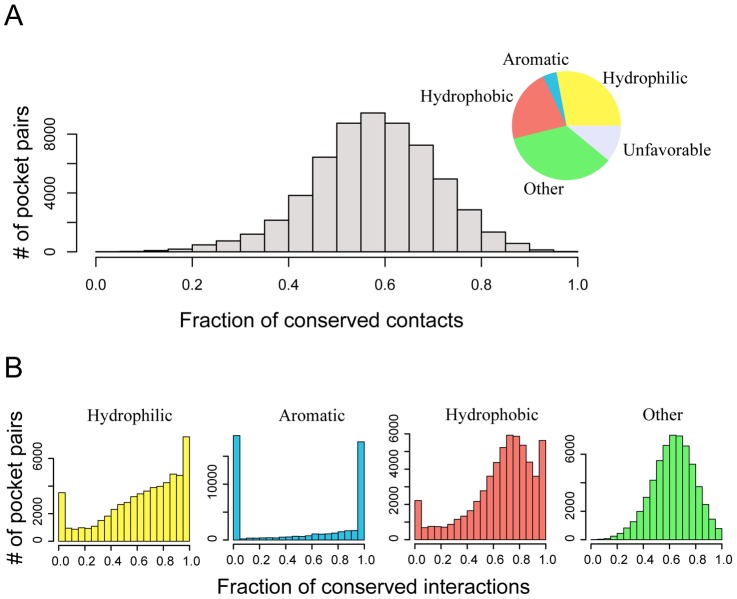
Distribution of conserved contacts between dissimilar ligands (Tc<0.3) bound to the same pockets.(A) Overall distribution of all conserved contacts that are not unfavorable. The inserted pie chart shows ligand-protein interactions by type according their contributions to the overall contact surface area. (B) Distributions of individual types of ligand-protein interactions that are conserved between two pairs of ligand/pocket interactions.